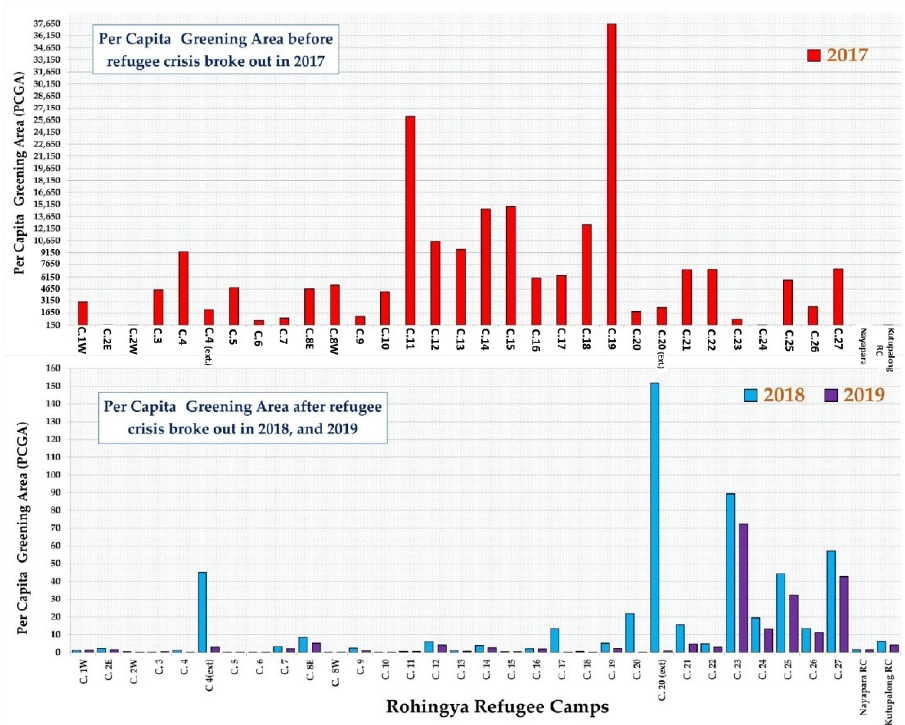
Figure 8. Per capital greening area (in hectares) of thirty-four Rohingya refugee camps in Ukhiya-Teknaf of Bangladesh, pre and post refugee influx, between 2017 and 2019.